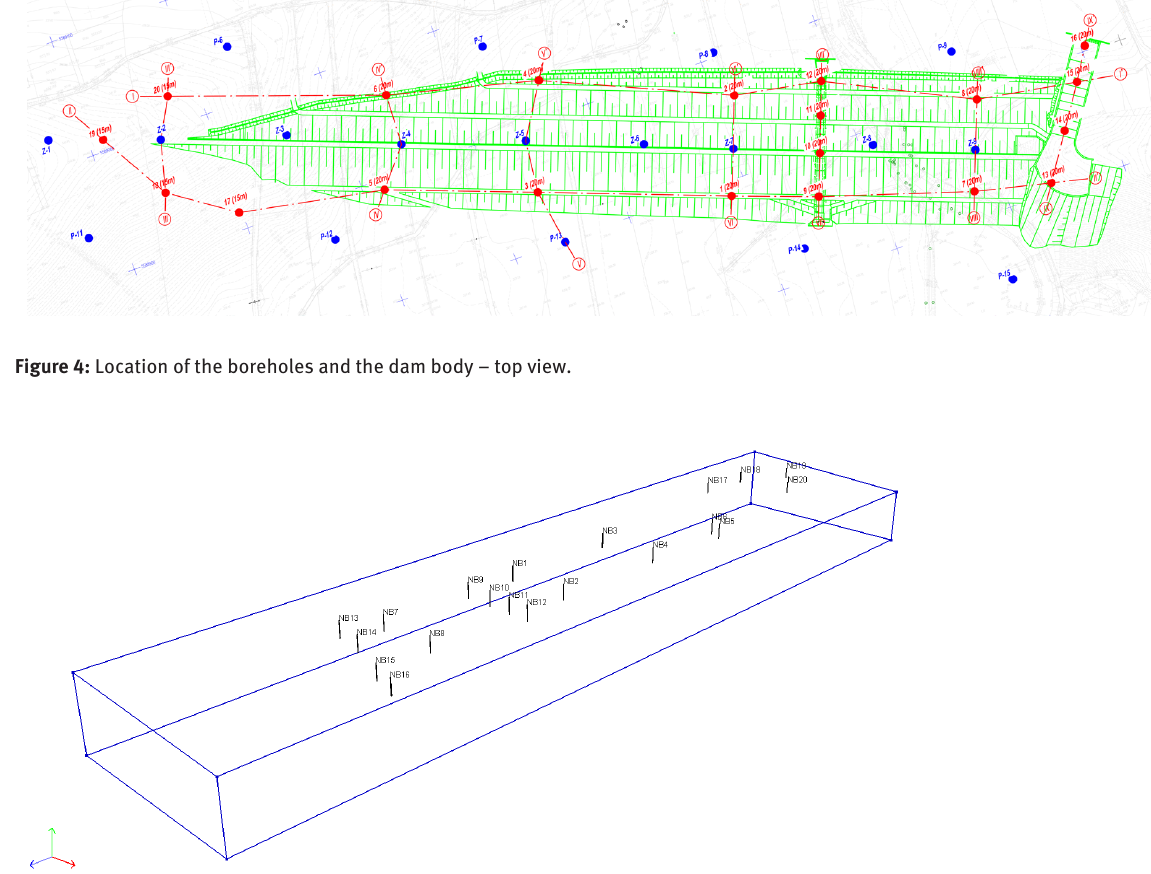
Figure 5: Location of the boreholes data input to the FE